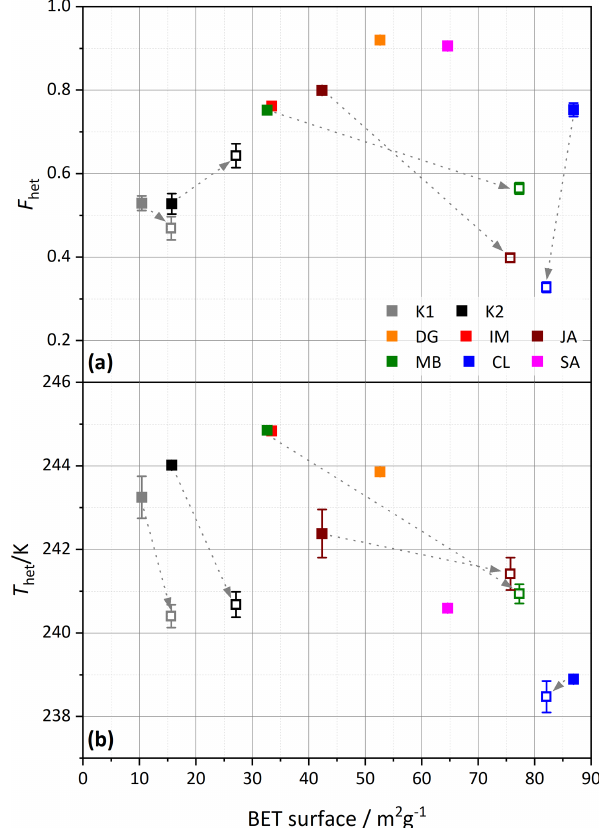
Figure 12. Similar to Fig. 11, (a) F het and (b) T het but are here plotted against the BET surface area derived from DVS measure- ments (analyzed between 15%–35% RH). Filled symbols depict untreated samples, and open symbols are milled samples. The sam- ples are color coded as indicated by the legend in the top panel. The dashed arrows point from the untreated sample to the corresponding milled sample. Dust sample codes are identical to those in Fig.